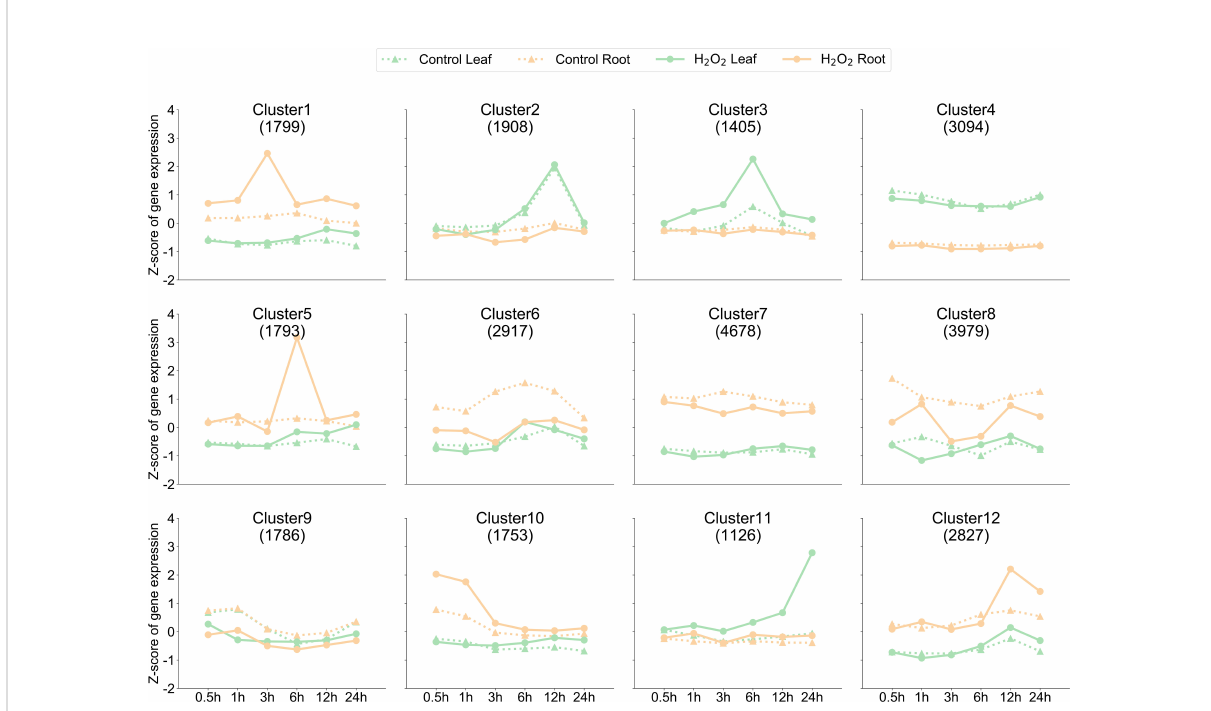
FIGURE 2 Dynamics of gene expression in the samples. K-means clustering grouped the expression pro fi les of the transcriptome into 12 clusters. The x- axis depicts the 24 samples, and the y-axis depicts the Z-score standardized cluster gene expression trend. The numbers shown in each box (for example, 1,799 genes for Cluster 1) were derived from the number of